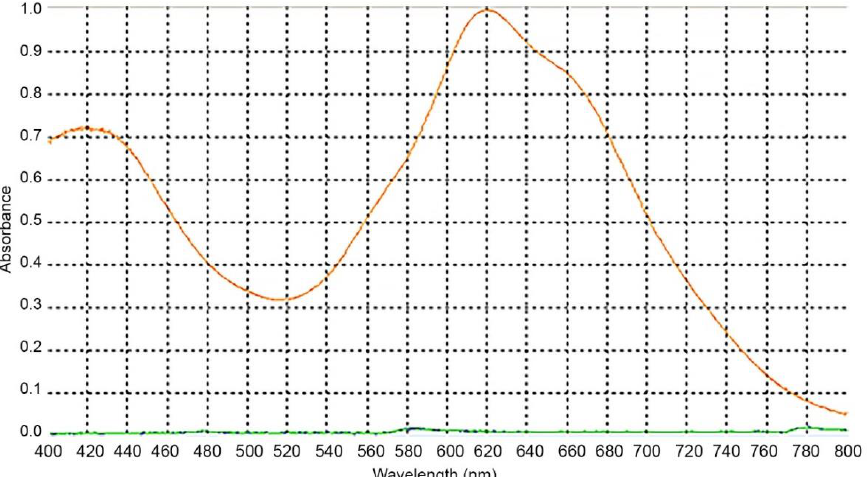
Figure 3. Absorption spectrum containing 750 μ L of cholesterol solution with 250 μ L of Liebermann – Burchard reagent.